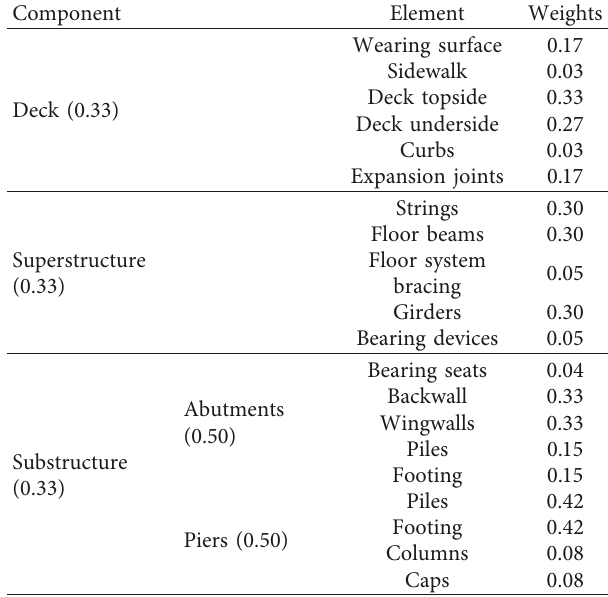
Table 5: Paired comparison of elements structural